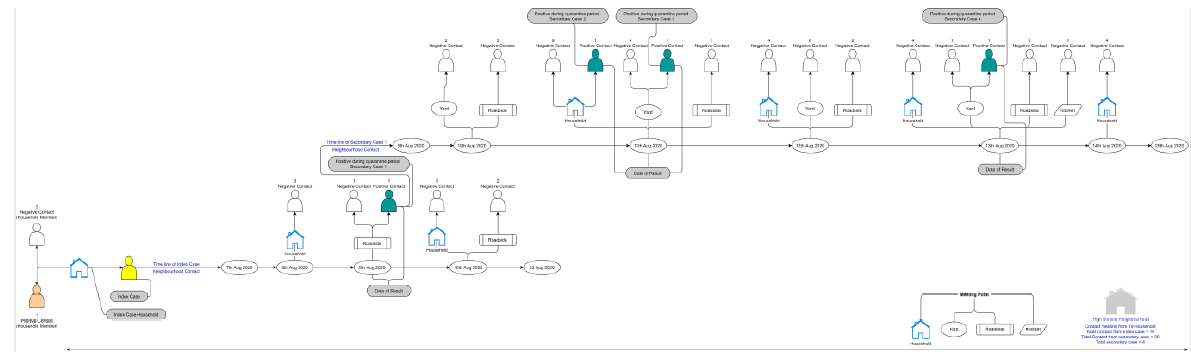
Figure A1. Diagram showing the setting of exposure and the direction of transmission from index case to household and neighborhood contacts in high-density areas in Dhaka city.